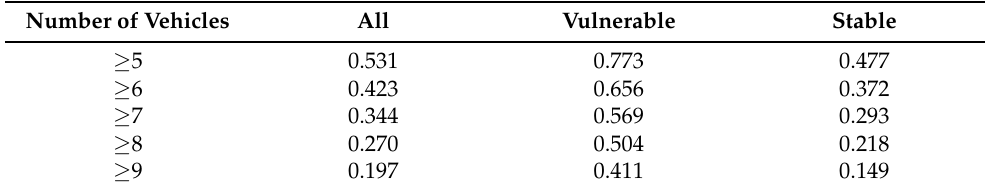
Table 4. Multiple vehicles’ proportion in different datasets.